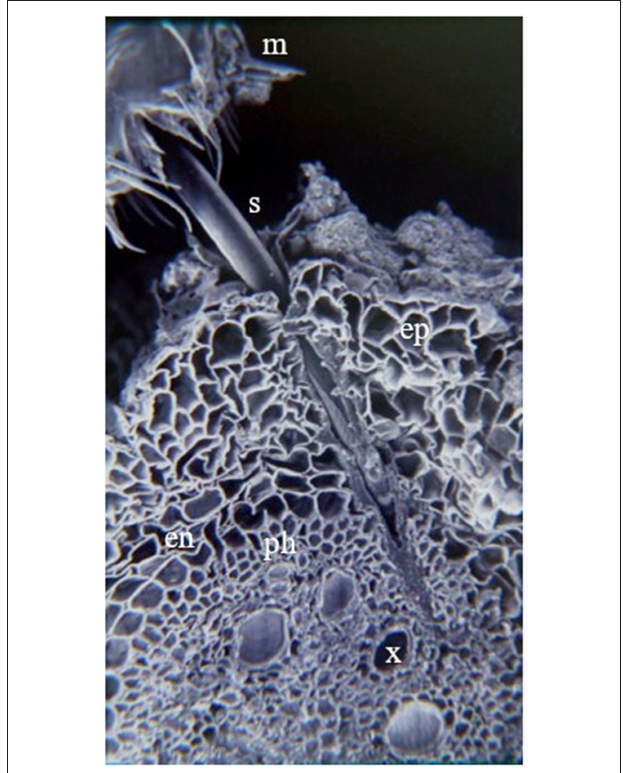
FIGURE 3 | Feeding site of A. varia nymph over U. ruziziensis root. Isect mouth (m), Stylet (s), epidermis (ep), endodermis (en), phloem (ph) and xylem (x). Picture taken from the archive of the forage entomology laboratory – CIAT.